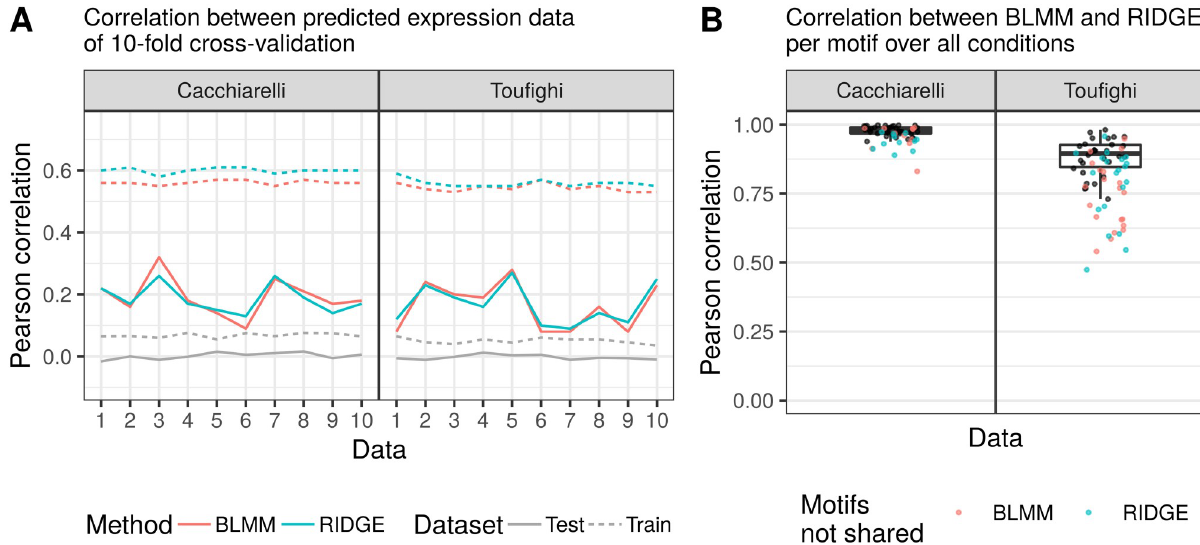
Fig 6. Data application on time-series datasets. (A): Pearson correlation between training set and predicted expression signal on training set and between test set and predicted test expression signal of a ten-fold cross-validation. In gray, the mean Pearson correlation between predicted and real signal using Bayesian Linear Mixed Model (results for Ridge Regression are almost identical) with a 1000-fold randomization of motif scores is shown. (B): Pearson correlation values per condition between the predicted motif weights ^ o